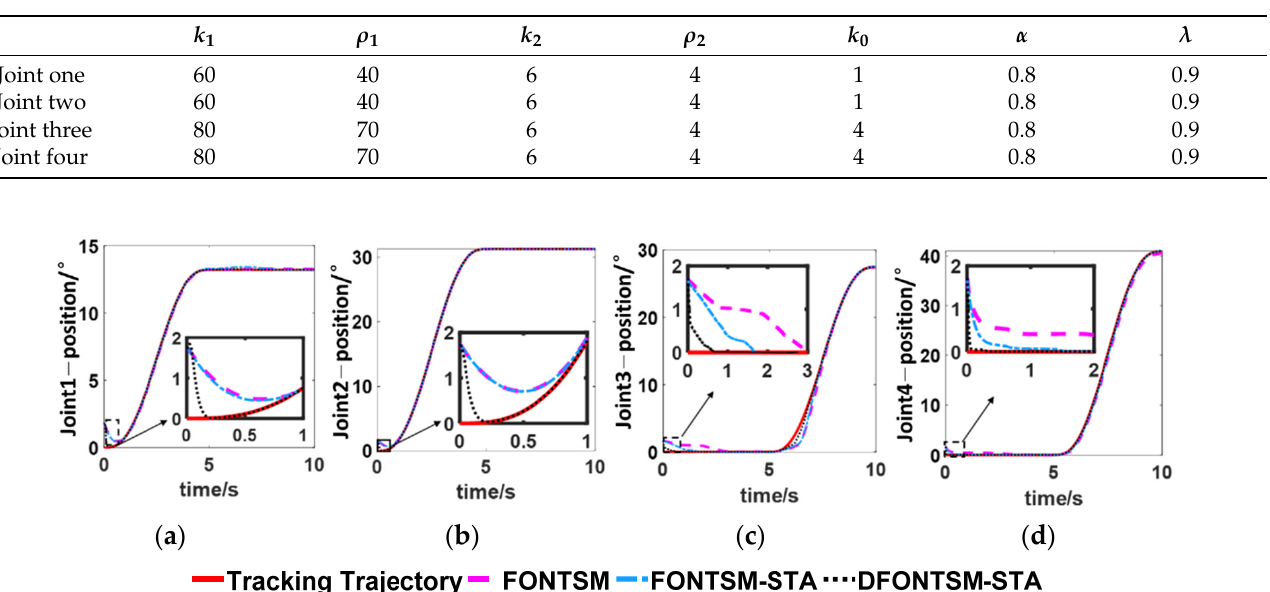
Table 6. Parameters list of fractional-order nonsingular terminal super-twisting sliding mode (FONTSM-STA) control and fractional-order nonsingular terminal sliding mode (FONTSM) con- trol.